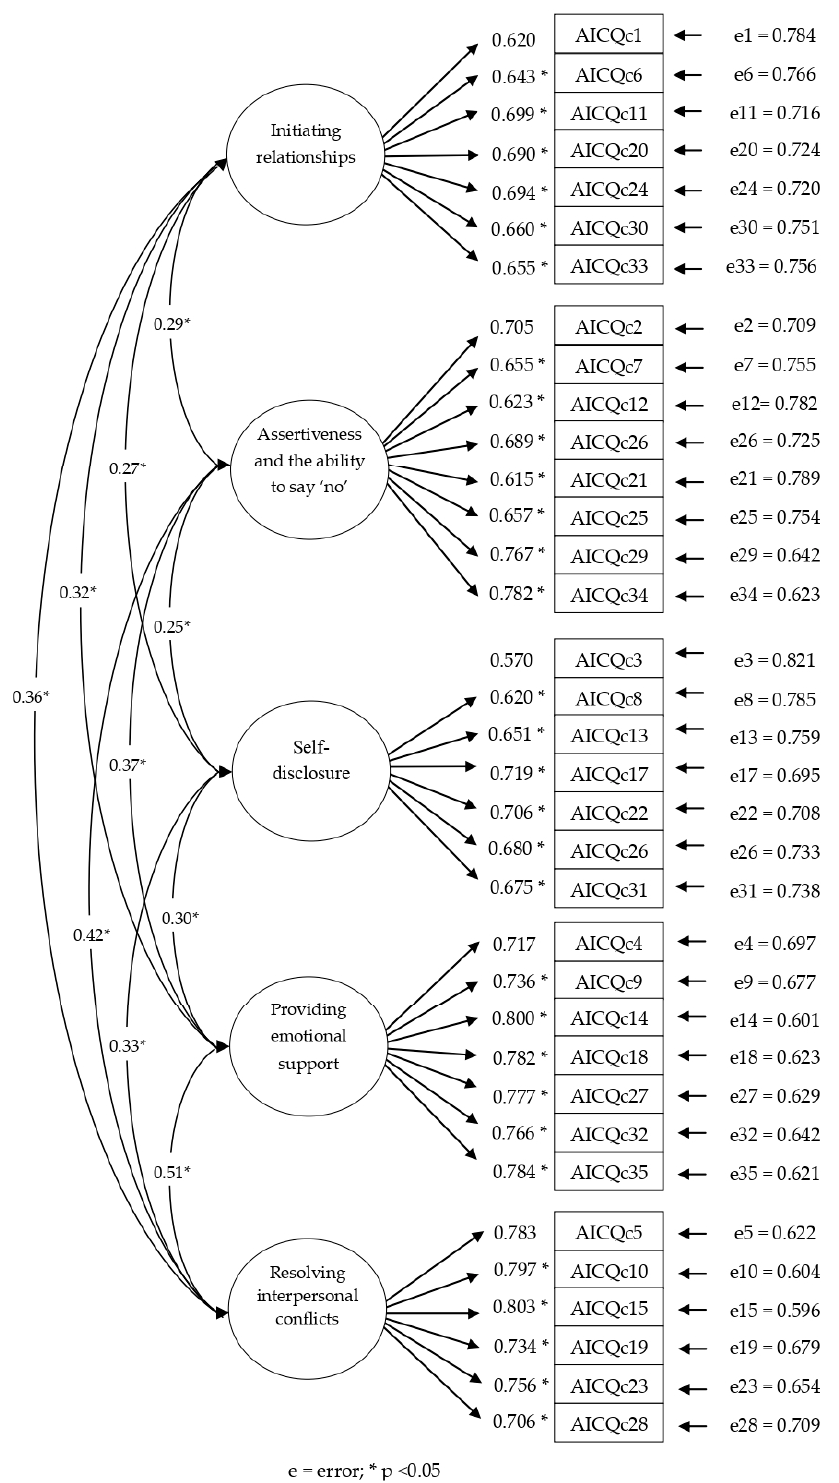
Figure 1. Standardized solutions for the Confirmatory Factor